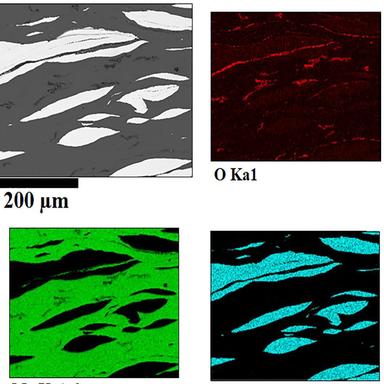
EDS elemental mapping analysis results from the structure of accumulative fold-forged magnesium-nickel layered composite.